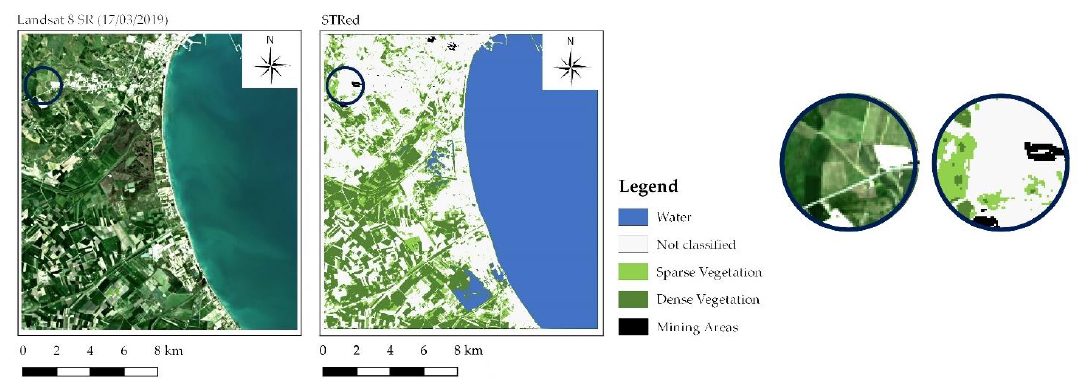
12 of 26 Figure 6. Normalized Difference Bareness Index 2 (NDBaI2) classification outcome for Landsat 8 (image acquired on 17 March 2019). On the right, zoomed images with some misclassifications. As described in Section 2.2, LICA consisted of two different steps: The former intended to classify water, mining areas, and dense and sparse vegetation (Figures 7–9); the latter aimed at